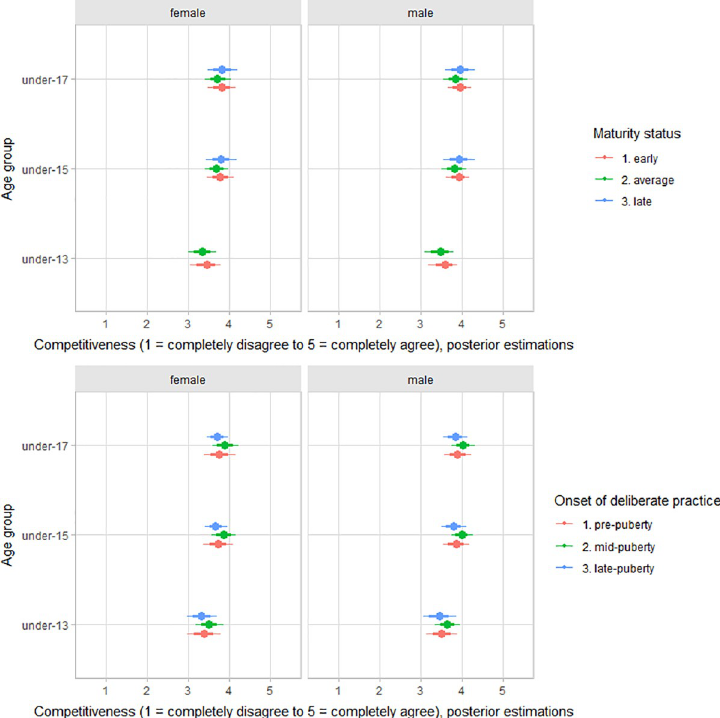
Fig 6. Posterior estimations and uncertainty (bold lines and thick ones represent 67% and 90% intervals, respectively) for competitiveness score by age group and contrasting age group by maturity status (upper plot), and the onset of deliberate practice (lower